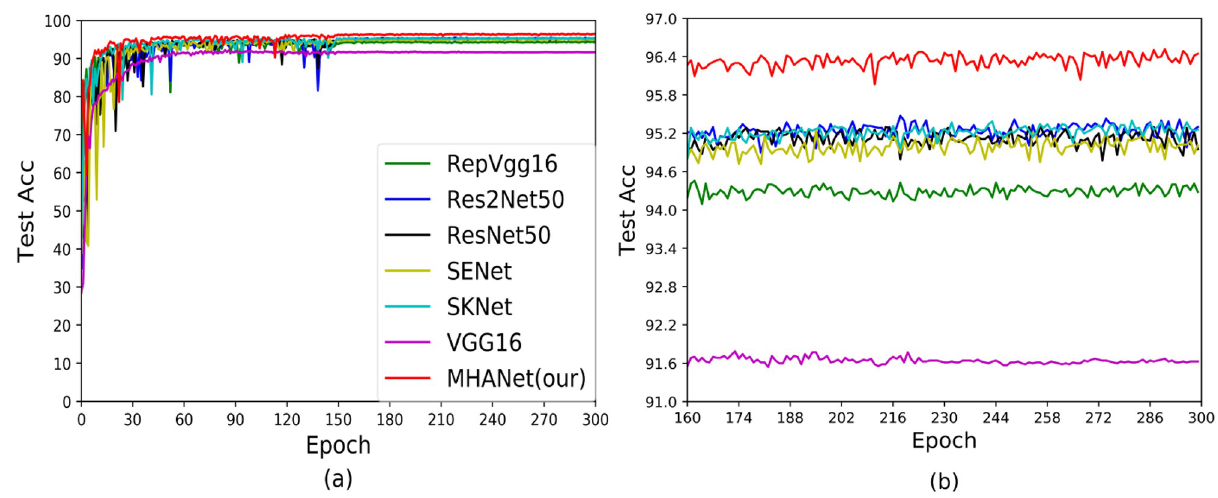
Fig 8. Test accuracy curves of